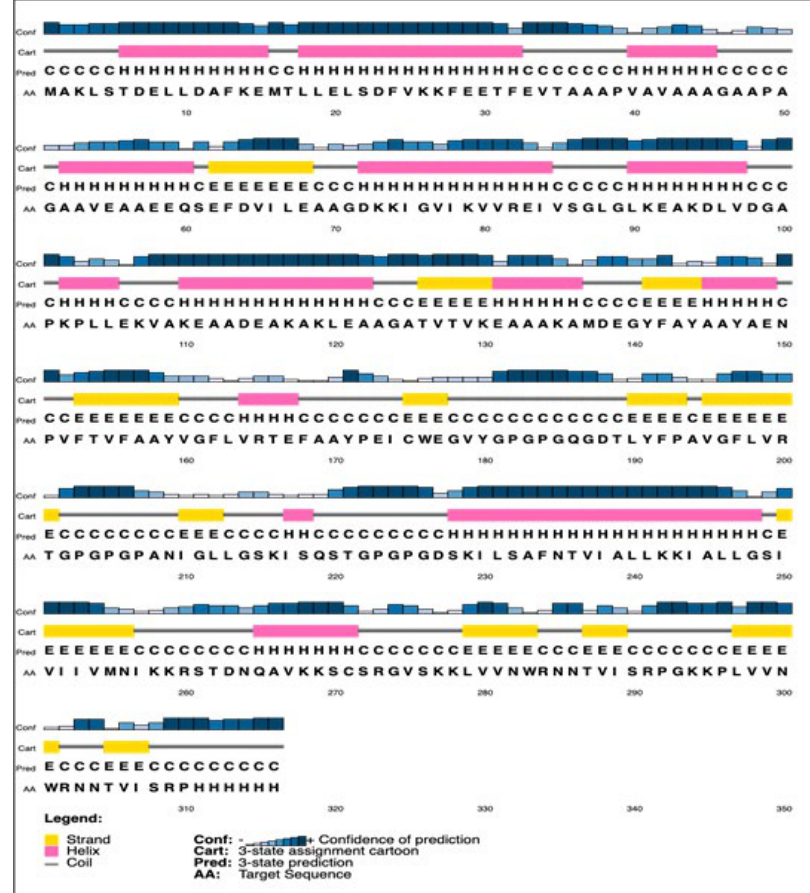
Fig. 6. Secondary structure prediction by PSPIRED server